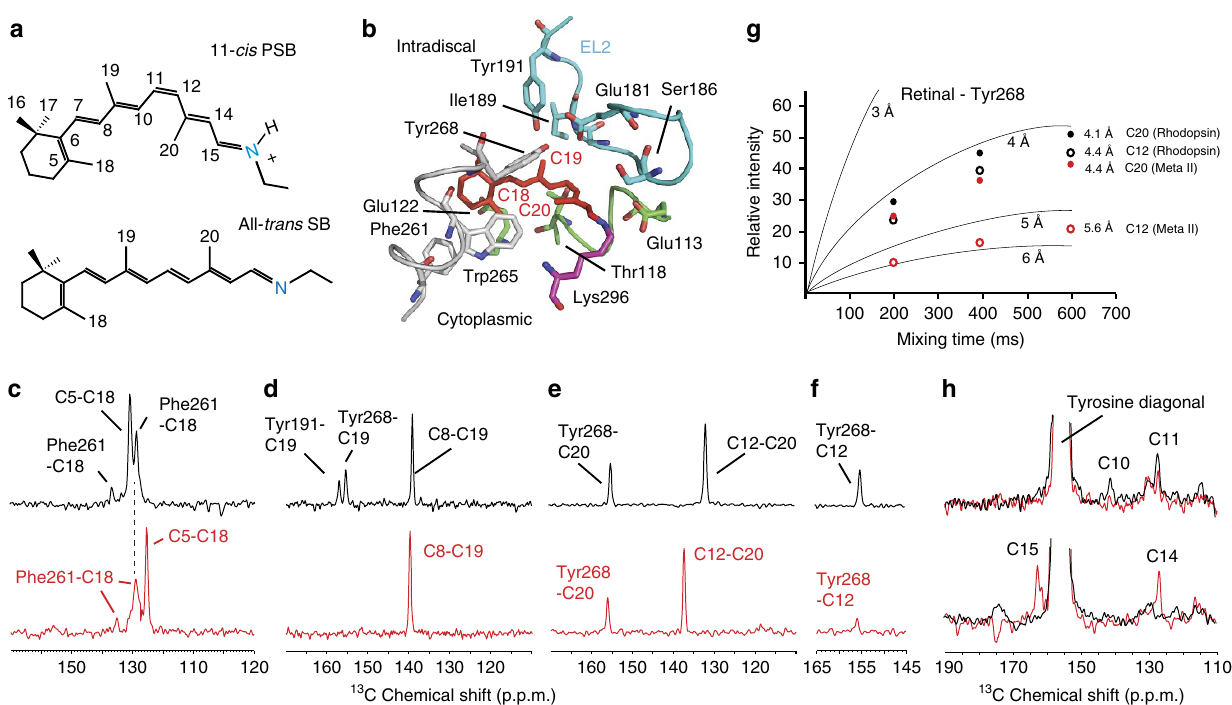
Figure 1 | Retinal–protein contacts in dark-state rhodopsin and Meta-II. ( a ) Structure of the 11- cis retinal PSB and all- trans retinal SB in rhodopsin and Meta-II, respectively. ( b ) Crystal structure of rhodopsin (PDB-ID 1U19; ref. 26) showing interactions of the C18, C19 and C20 retinal methyl groups with surrounding residues. ( c ) Retinal C18 contacts with phenylalanine and tyrosine in rhodopsin and Meta-II. Rows through the 13 C18 diagonal resonance are shown from 13 C DARR NMR experiments of rhodopsin (black) and Meta-II (red) obtained with the receptor regenerated with 13 C5, 13 C18 retinal and incorporating 13 C-ring-labelled phenylalanine and 13 C z -labelled tyrosine. Since the chemical shifts can change between rhodopsin and Meta-II, the rows selected correspond to the diagonal chemical shifts of the 13 C18 resonance in rhodopsin at 21.6p.p.m. and Meta-II at 20.9p.p.m. These rows maximize the crosspeak intensities. ( d ) Retinal C19 contacts with tyrosine. Rows through the 13 C19 diagonal resonances in rhodopsin (black) at 14.7p.p.m. and Meta-II (red) at 13.8p.p.m. obtained with the receptor regenerated with 13 C8, 13 C19 retinal and incorporating 13 C-ring Phe and 13 C z -labelled Tyr. ( e , f ) Retinal C12, C20 contacts with tyrosine in rhodopsin and Meta-II. Rows through the 13 C20 diagonal resonances in rhodopsin (black) at 16.4p.p.m. and Meta-II (red) at 13.7p.p.m. obtained with the receptor regenerated with 13 C12, 13 C20 retinal and incorporating 13 C z -labelled Tyr. ( g ) Build-up curves for the observed retinal–tyrosine crosspeaks in rhodopsin (black) and Meta-II (red) scaled to the C12-C20 crosspeaks. The C12-C20 retinal distance is fixed at B 2.4Å. The retinal C12 and C20 distances to the C z carbon of Tyr268 6.51 range from B 4 to 6Å (Supplementary Table 3). The retinal-Tyr268 6.51 data are compared with build-up curves derived from model compounds and fixed distances in rhodopsin. The error in the measurements is ± 0.3Å on the basis of the signal-to-noise of the NMR spectra. ( h ) 13 C z -Tyr268 6.51 crosspeaks with the retinal 13 C10,11 resonances (top) and the 13 C14,15 resonances in rhodopsin (black) and Meta-II (red). Rows are taken through the 13 C z -Tyr diagonal resonance at 155.2p.p.m. in rhodopsin and 156.1p.p.m. in Meta-II.